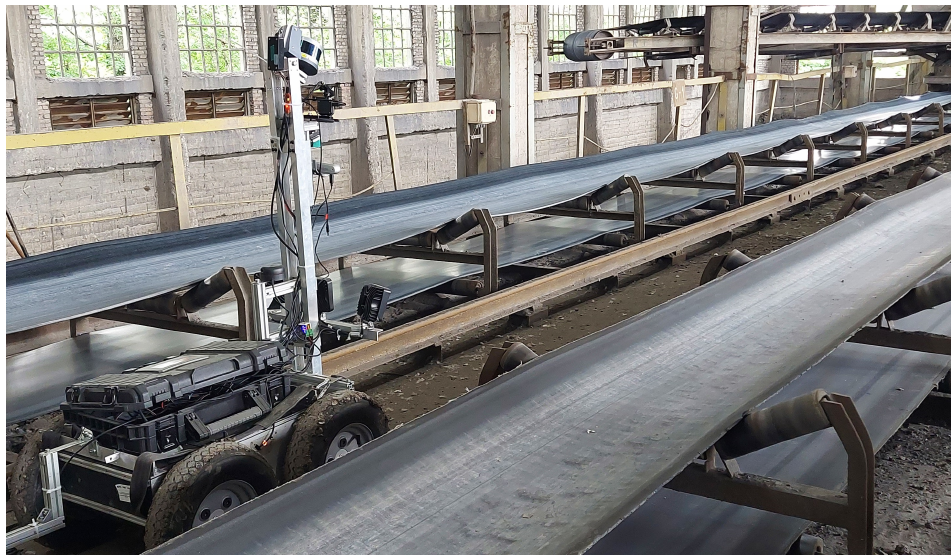
Figure 1. View of the robot during inspection.